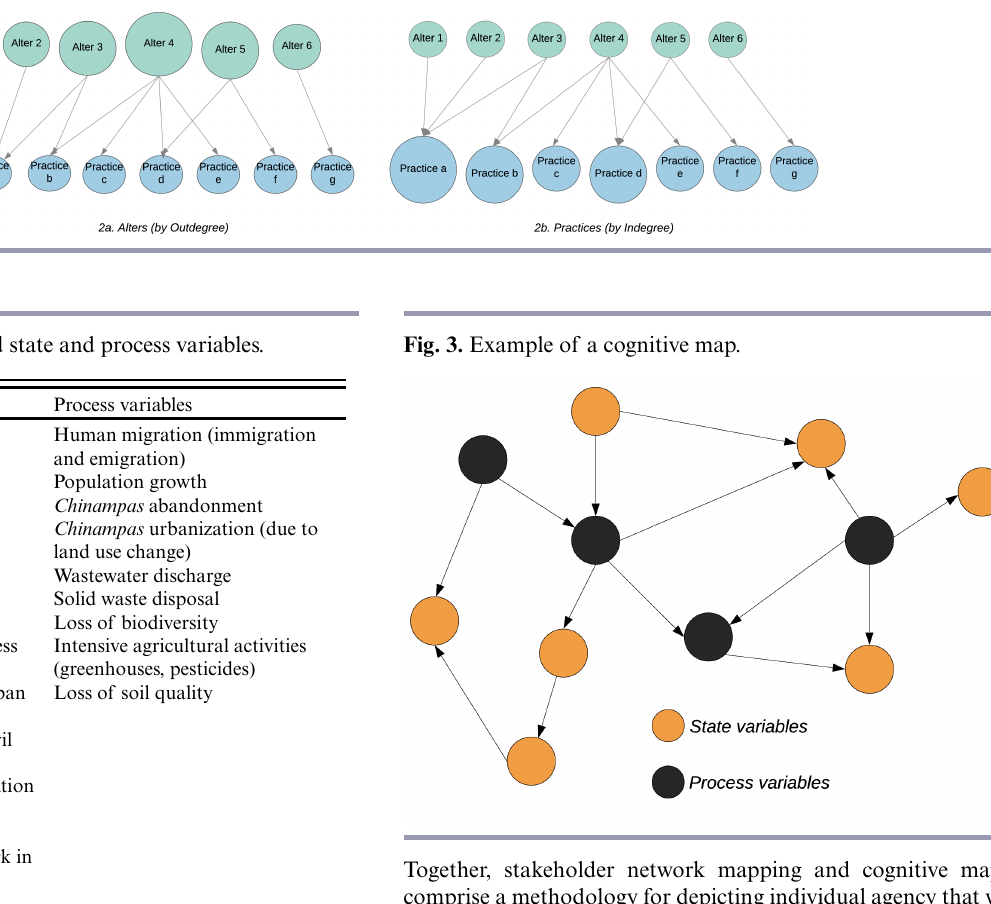
Fig. 2. Examples of action-nets for alters (A) and practices (B).